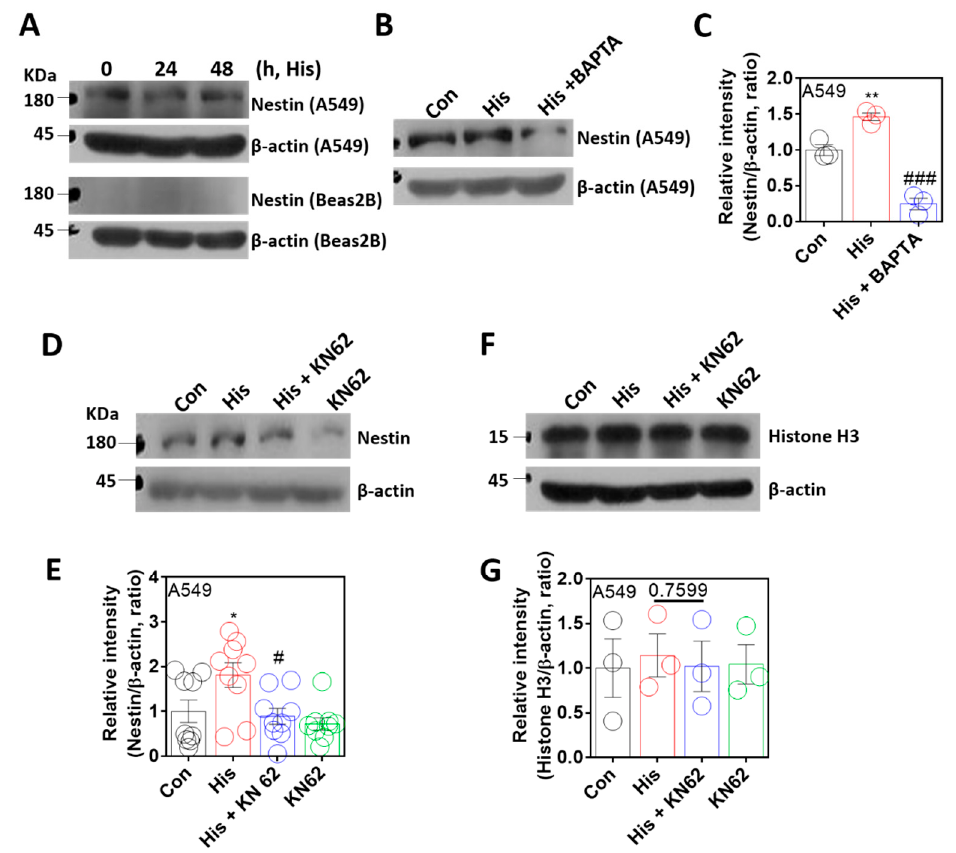
Figure 4. Nuclear protein nestin expression was modulated by Ca/CaMKII. ( A ) Protein expression levels of nestin after histamine (His) treatment (100 µ M, 24 h and 48 h) in both A549 (upper panels) and Beas2B (lower panels) cells. β -actin was used as a loading control. ( B ) Protein expression levels of nestin after histamine treatment (100 µ M, 24 h) with and without BAPTA-AM (BAPTA; 10 µ M, 24 h) in A549 cells. ( C ) The graph indicates the relative intensity of nestin. β -actin was used as a loading control. The bars represent the mean ± SEM ( n = 3, ** p < 0.01 vs. control and ### p < 0.001 vs. His-treated group). ( D ) Protein expression levels of nestin after histamine treatment (100 µ M, 24 h) with or without KN-62 (10 µ M, 24 h) in A549 cells. ( E ) The graph indicates relative intensity of nestin. β -actin was used as a loading control. The bars represent the mean ± SEM ( n = 9, * p < 0.05 vs. control and # p < 0.05 vs. His-treated group). ( F ) Protein expression levels of Histone H3 after histamine treatment (100 µ M, 24 h) with or without KN-62 (10 µ M, 24 h) in A549 cells. ( G ) The graph indicates relative intensity of Histone H3. β -actin was used as a loading control. The bars represent the mean ± SEM ( n = 3).